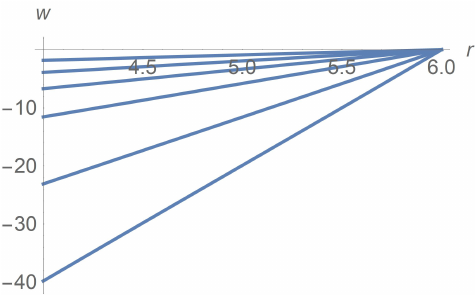
Figure 9. ( a ) Calculated dimensionless velocity profiles for φ = 0.3. The curves correspond to Ω = 2,5,10,20,50,100 [ rpm ] from the bottom upwards. ( b ) Measured [9] dimensionless velocity profiles of the Herschel–Bulkley fluid with φ = 0.3 and Ω taking values 2,5,10,20,50,100 [ rpm ] from the bottom upwards.